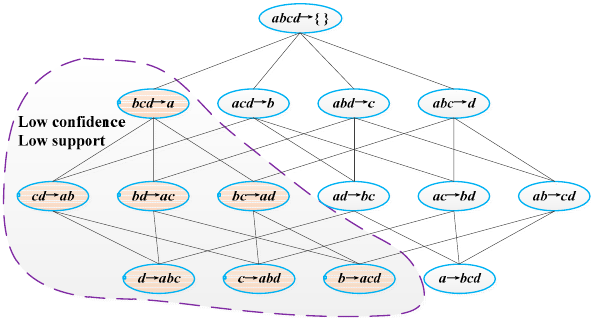
Figure 2. The implementation process of the a priori algorithm. Simple association rules are generated from the frequent item sets, and association rules with confidence levels greater than the threshold value are selected to form an effective rule set. If C is greater than the confidence threshold specified by the user (see L (cid:48) → ( L − L (cid:48) ) Equation (2)), then the association rule can be generated.